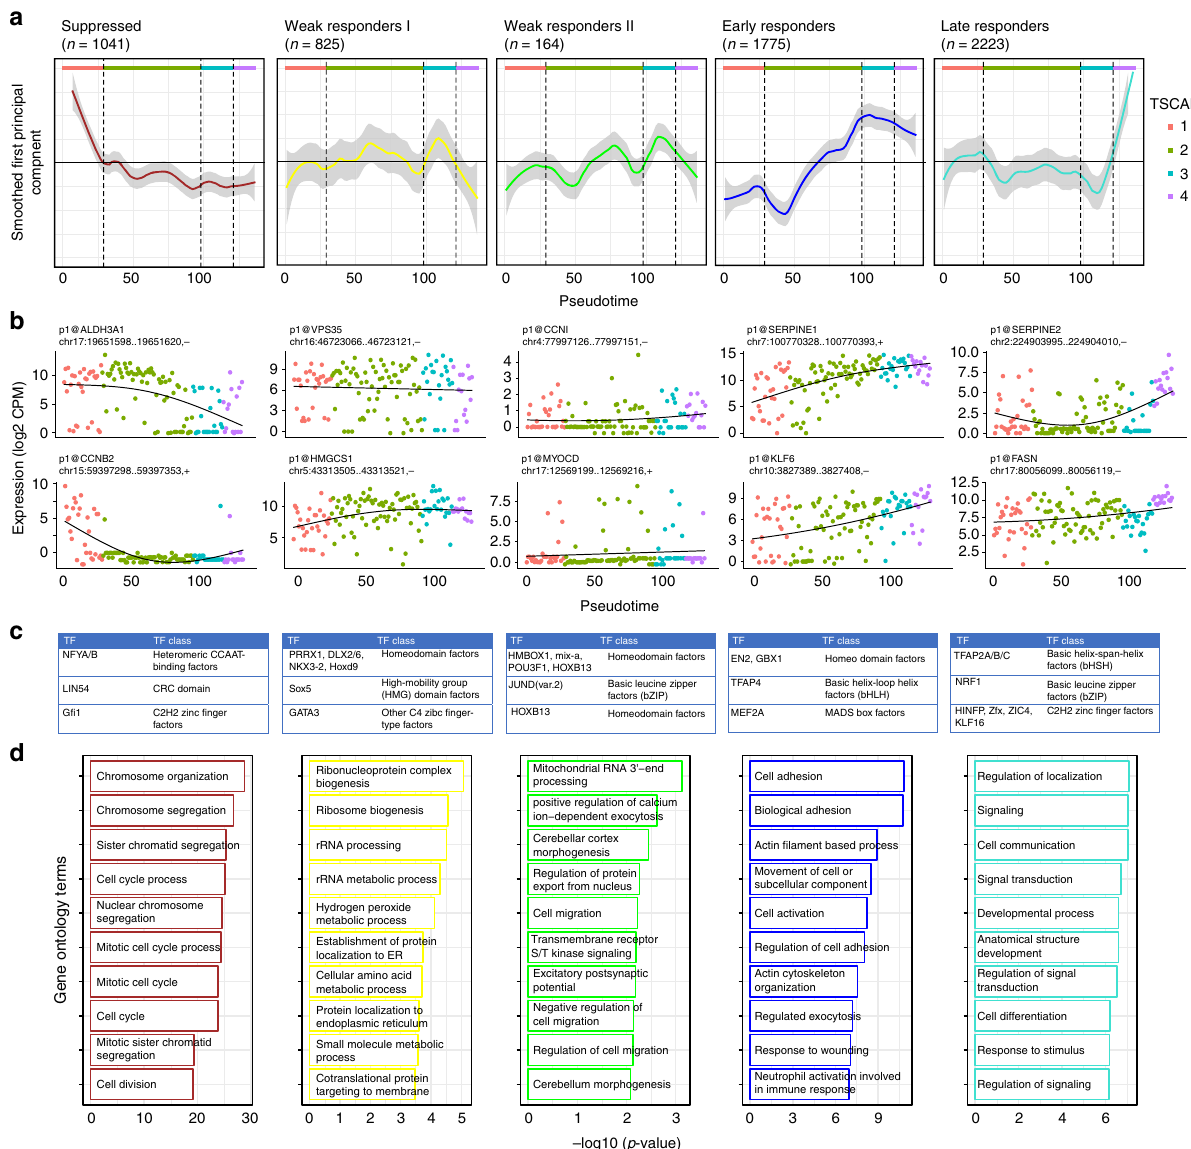
Fig. 3 WGCNA clusters of response to TGF- β . a CAGE cluster expression pro fi les for 5 WGCNA modules, 3 of which show a clear response to TGF- β (suppressed, early responders, and late responders). The curves are smoothed with the loess R function. b Example CAGE cluster expression pro fi les from each module. c Top three enriched TF binding pro fi les in each module. d Functional analysis using edgeR ’ s implementation of GOseq. Top over-represented GO terms for biological processes are shown. Source data are provided as a Source Data fi